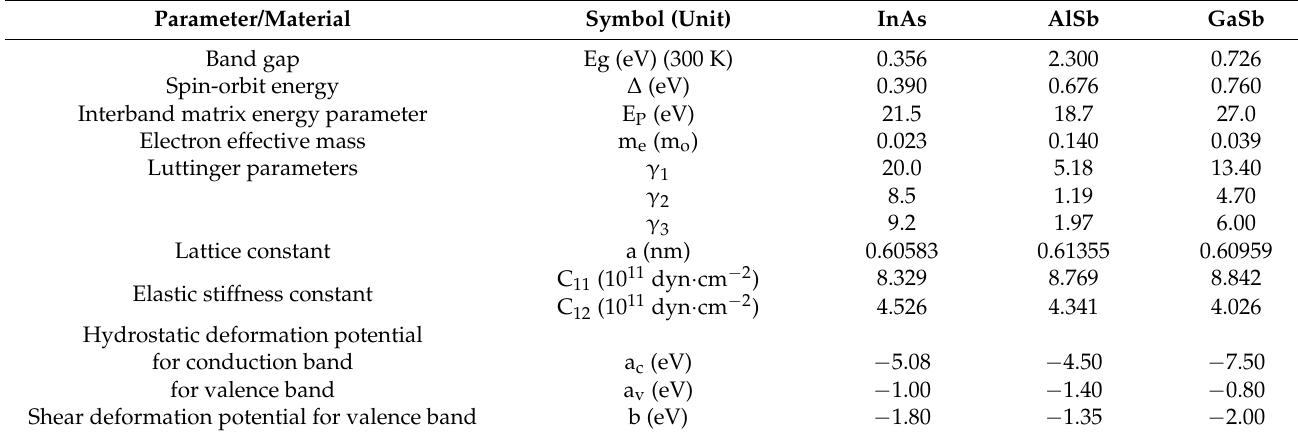
Table 1. Material parameters for the